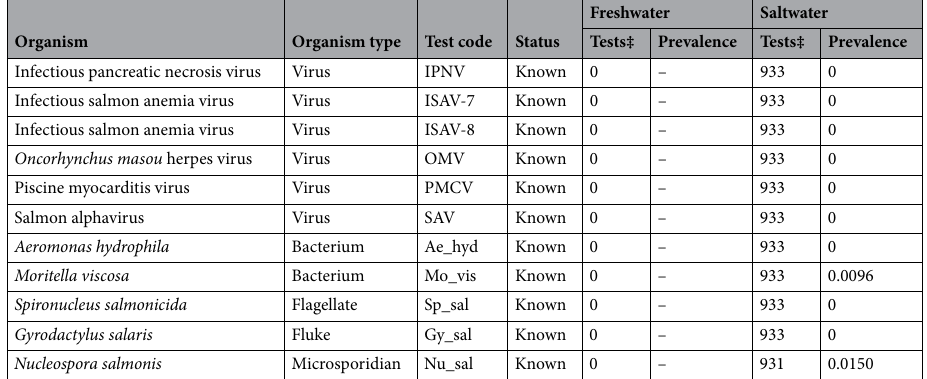
Table 2. Low-prevalence infective agents in initial rounds of mixed-tissue sample screening in farmed Atlantic salmon. ‡ successful tests only (i.e. those without evidence of control cross contamination, poor amplification curves, or low housekeeping gene